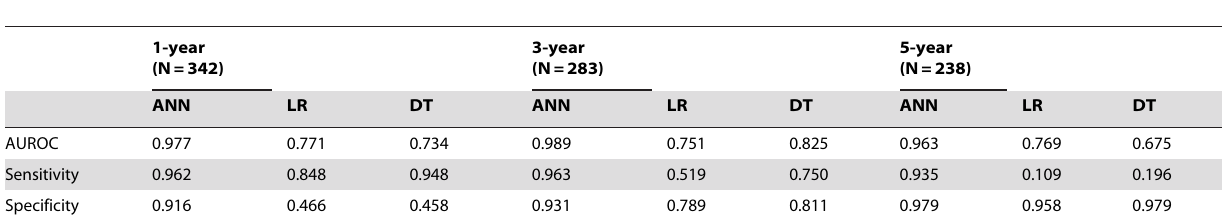
Table 3. Performance comparison of ANN, LR and DT models for predicting 1-, 3- and 5-year disease-free survival in training